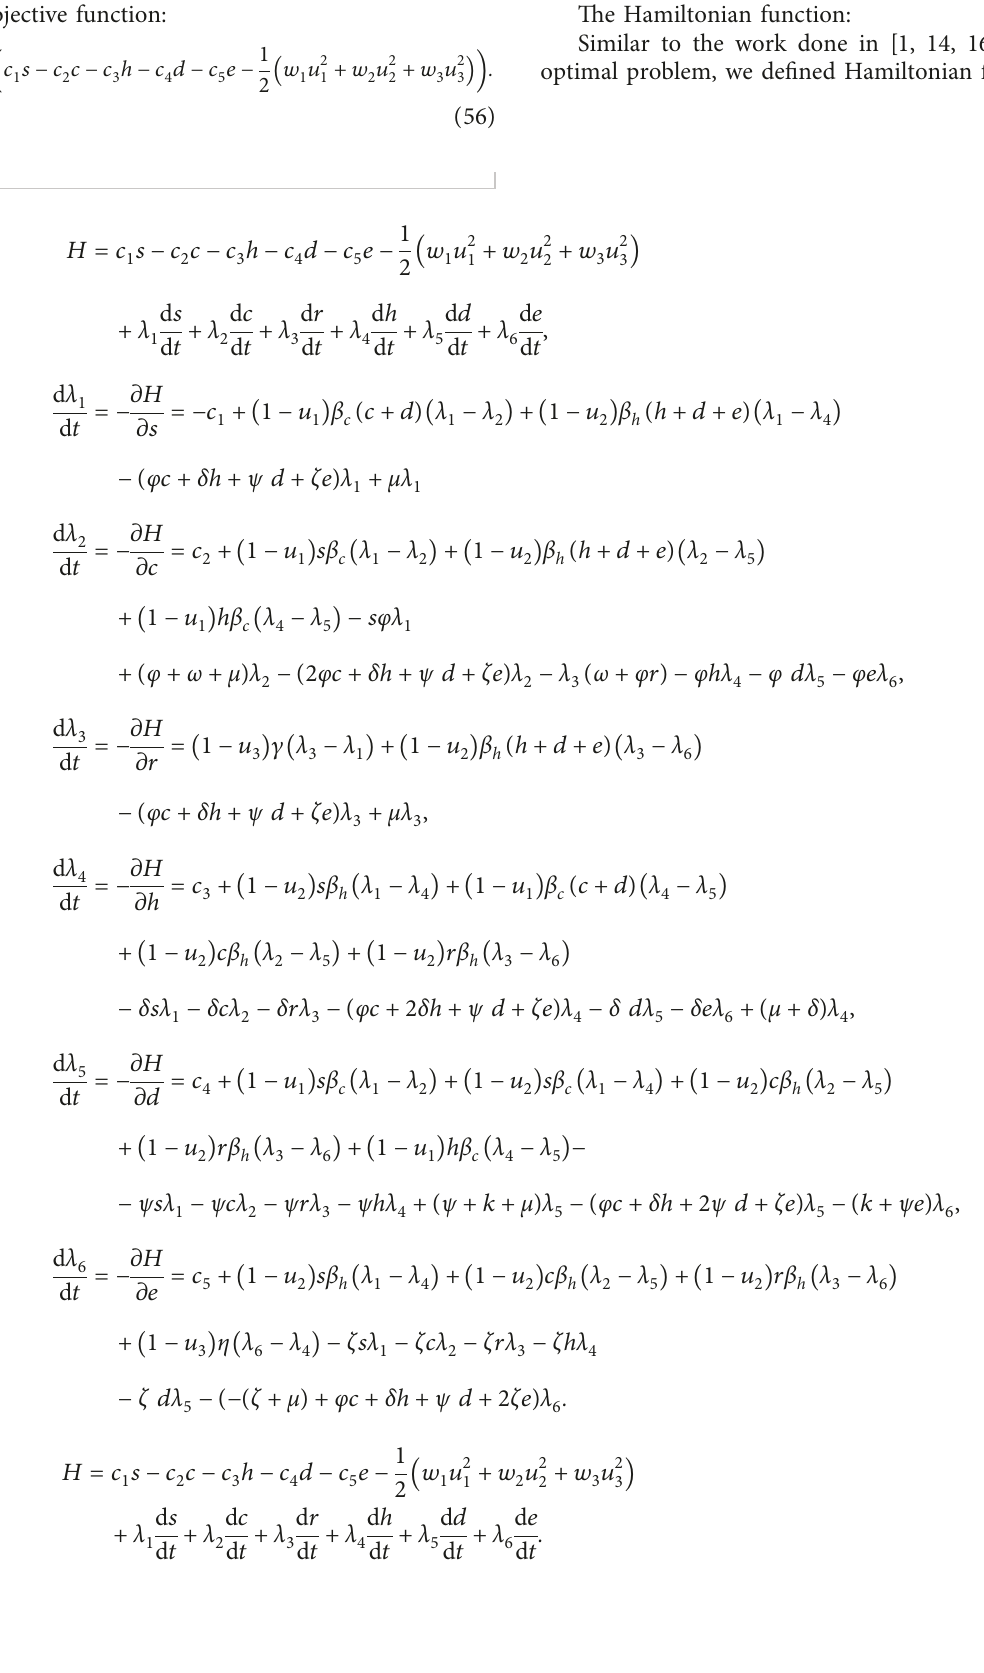
The Hamiltonian function: Similar to the work done in [1, 14, 16], to solve the optimal problem, we defined Hamiltonian function H